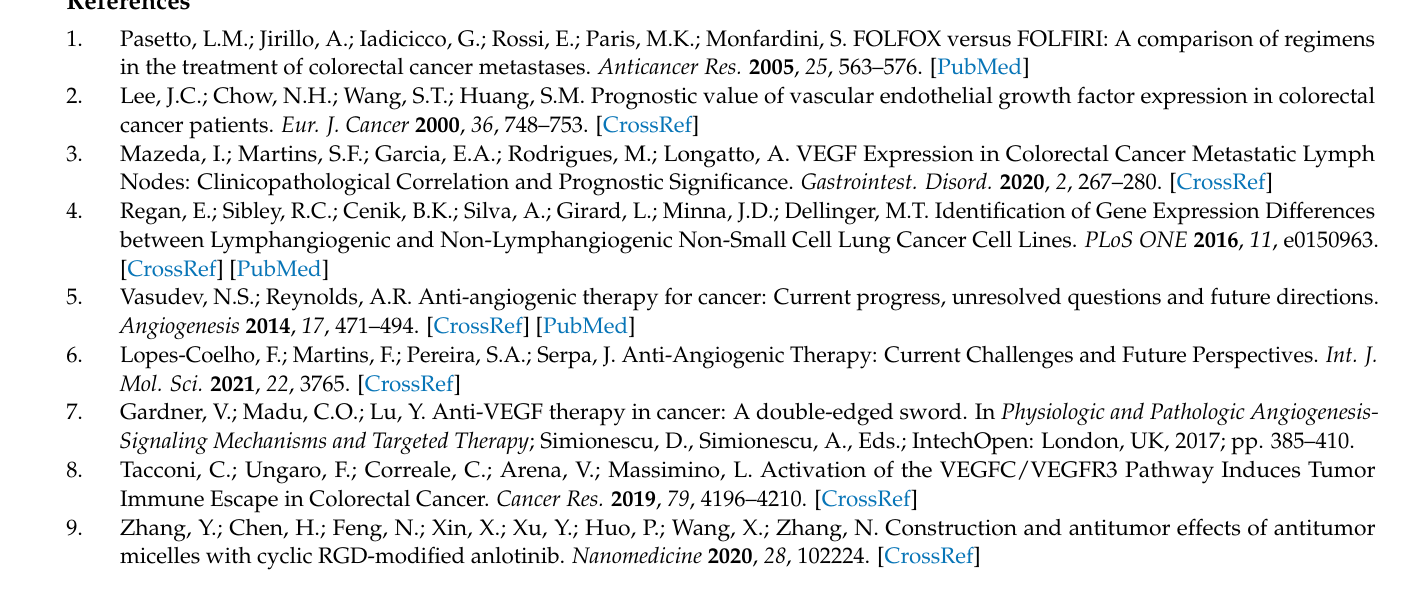
populations; Table S1: List of antibodies with conditions used for immunohistology; Table S2: List of antibodies with conditions used for flow cytometry; Table S3: T cell subset ratios in Liver and